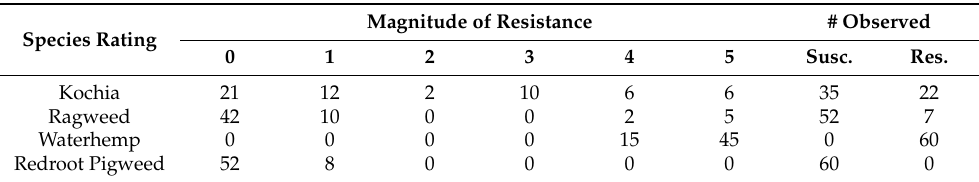
Table 3. Casselton Plant Survival Evaluation at 14 DAA.